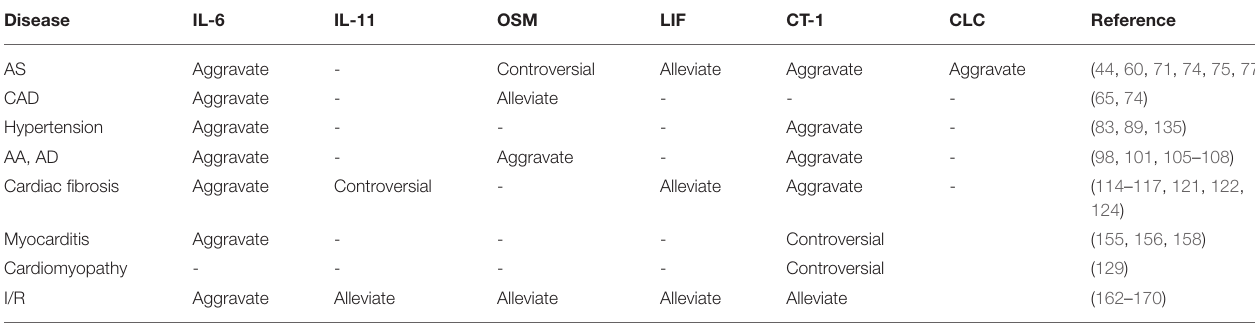
TABLE 3 | Regulation of IL-6 family members on cardiovascular disease. Disease